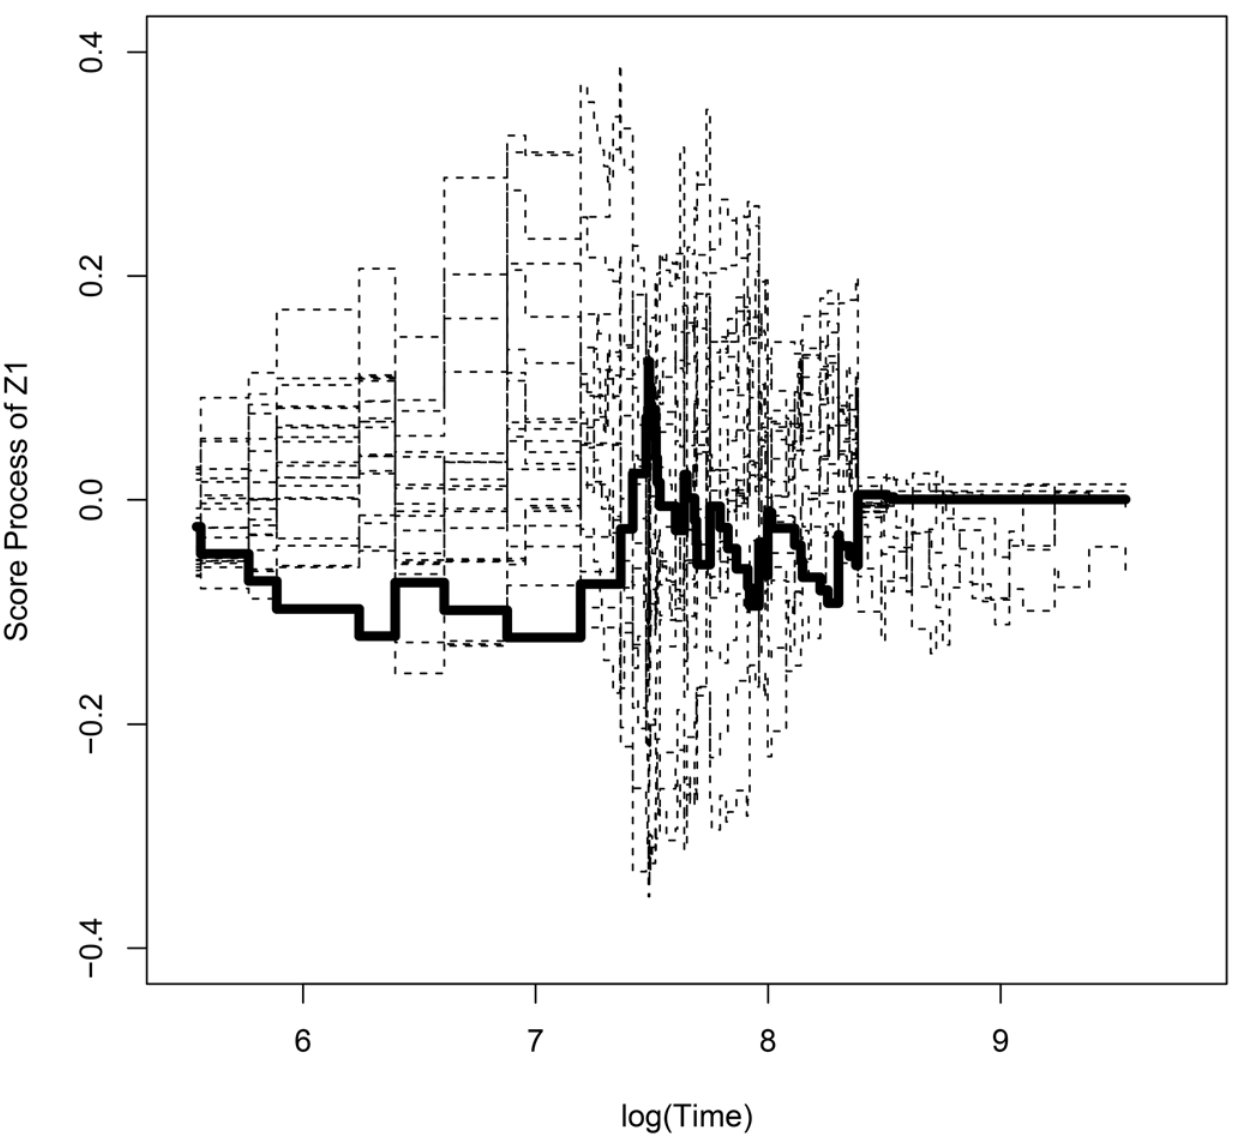
Fig 1. Plot of observed score process and bootstrapped processes of time to withdrawal of study with respect to Z 1 . The thickline is observed process and the dashed lines are bootstrapped processes